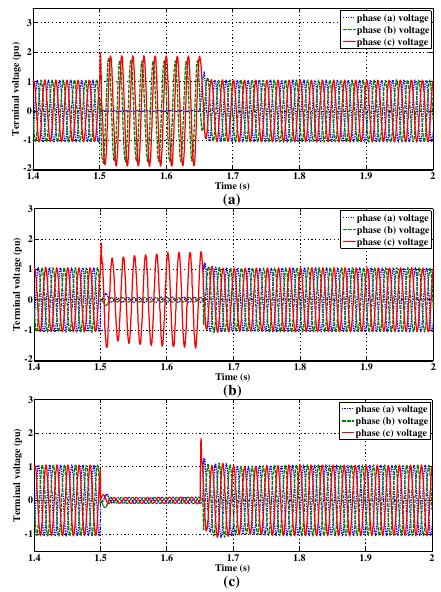
Fig. 8 Terminal voltage variations during different fault types ( a ) single-phase to ground fault; ( b ) double-phase to ground fault; ( c ) three-phase to ground